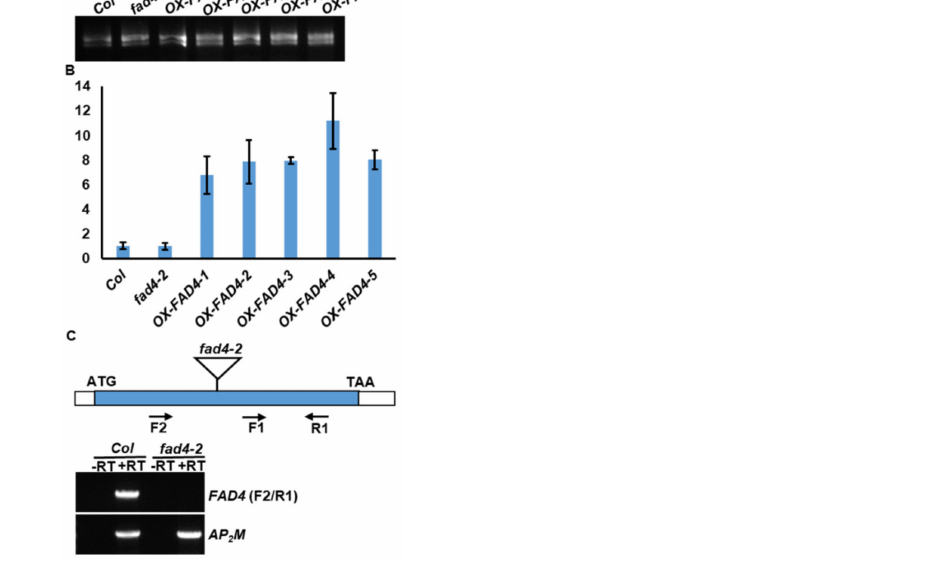
Figure 2. Overexpression or knockout of FAD4 in Arabidopsis . ( A ) Agarose electrophoresis of total RNA isolated from Col, fad4-2 and OX-FAD4s plants. ( B ) FAD4 expression levels measured by RT- qPCR. ( C ) T-DNA insertion in fad4-2 produces a long FAD4 chimera mRNA that may translate into a nonfunctional FAD4 protein. –RT: reverse transcription without M-MLV addition as negative control; +RT: reverse transcription with M-MLV addition. AP 2 M (At5g46630) was used as loading